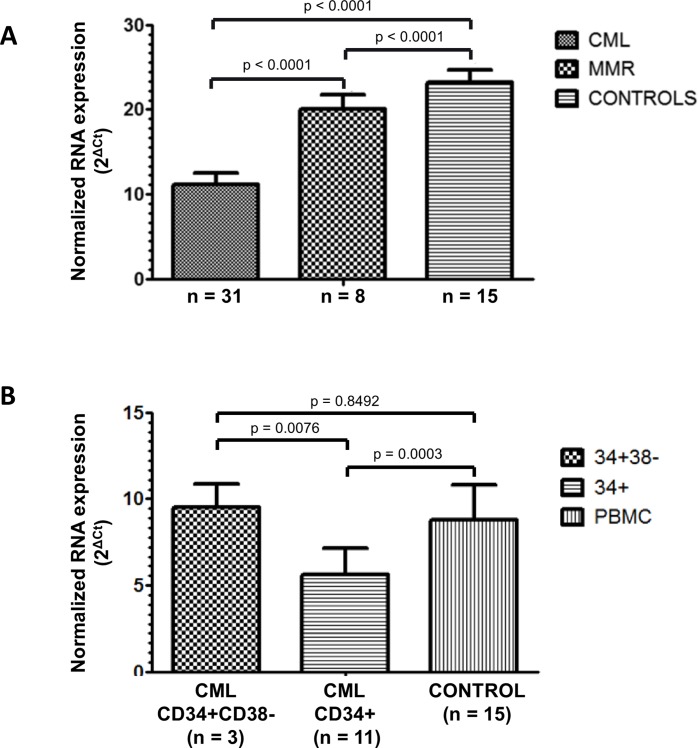
Expression of AHR in primary leukemic samples.(A) AHR transcript was quantified in primary peripheral blood CML cells at diagnosis (n = 31 patients) and were found to be very significantly reduced as compared to normal controls (n = 15) (p < 0.0001, ANOVA and Tukey’s post-hoc test). In 8 of these patients, AHR mRNA was quantified during TKI-induced major molecular response (MMR) and were found to increase towards levels found in controls in a statistically significant manner (p < 0.0001). Reported p values were adjusted for multiple comparisons. (B) AHR expression in CD34+ cells (n = 11) as well as in highly purified CD34+ CD38- cell populations (n = 3). Interestingly, AHR expression was reduced in leukemic CD34+ progenitors (n = 11) but not in more primitive leukemic CD34+ CD38- cells (n = 3, p = 0.0076) as compared to normal controls (n = 15).